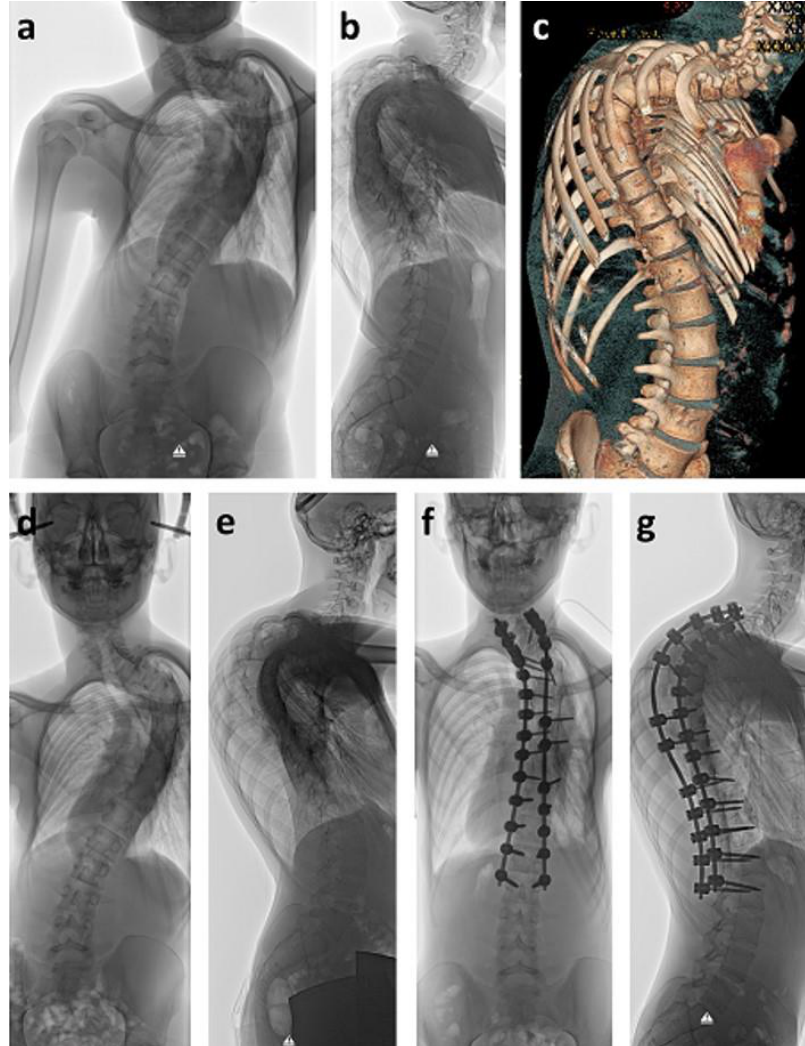
Figure 3. Fifteen-year old boy who was diagnosed with intraspinal astrocytoma at age ten.